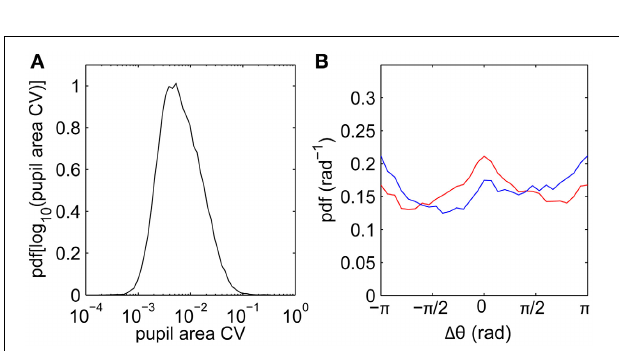
curves. Subjects 1–8 colored in order red, yellow, light green, green, cyan, light blue, blue, purple. (C) Scaling exponent for a surrogate walk with uncorrelated steps drawn from the empirical anisotropic step distribution in Figure 1C .